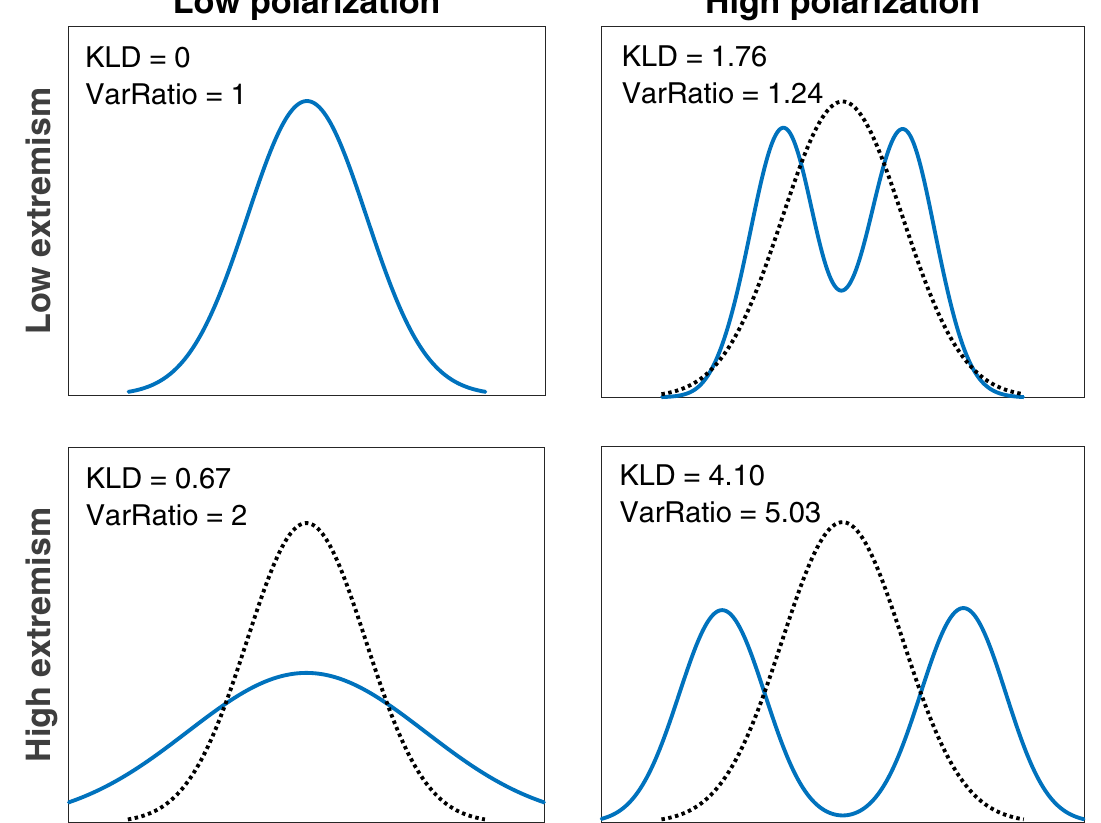
Figure 4. Diagram of the measures of polarization (low = left, high = right) and extremism (low = top, high = bottom), how different distributions of information might exemplify each of these properties, and how KLD and variance ratio (VarRatio) describe/quantify these properties. The dotted black line corresponds to the expected distribution, a normal distribution centered at zero, while the blue line corresponds to the observed distribution with high or low